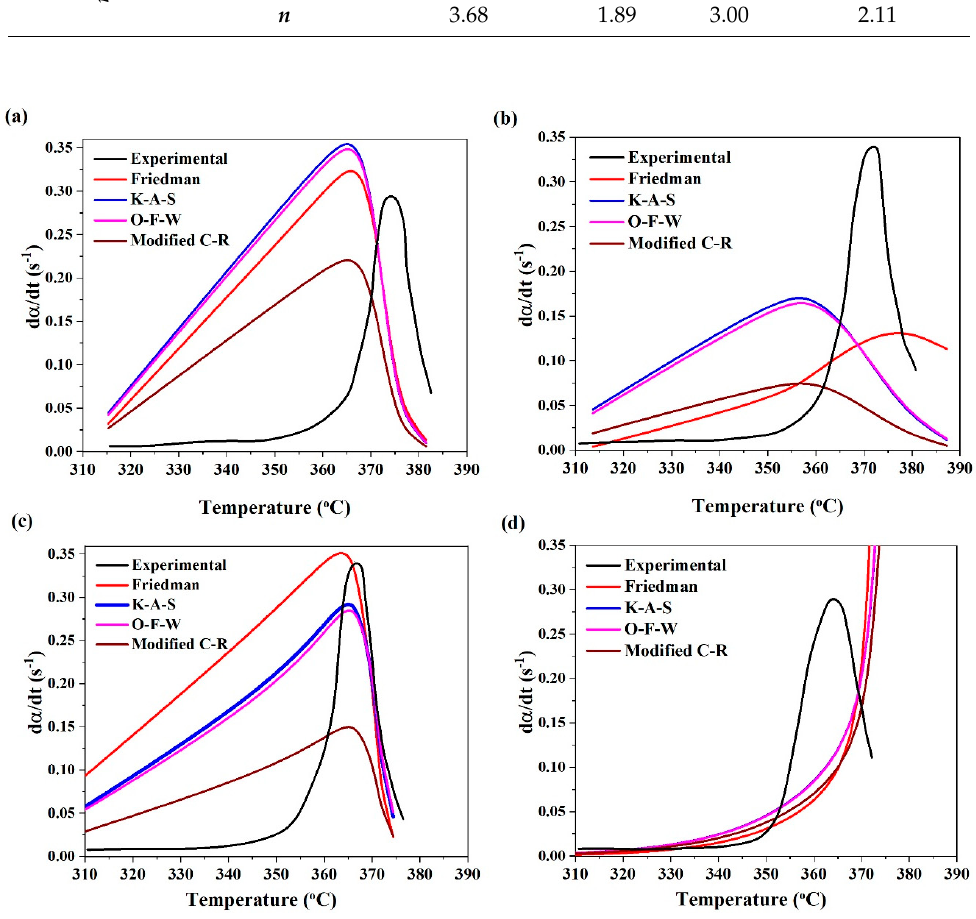
Figure 8. Predicted kinetics plots based on the n th order decomposition reaction model for blank PU and its nanocomposites containing various V-ZrO 2 loadings at the heating rate of 5 °C·min − 1 : ( a ) Blank PU; ( b ) PU/V-ZrO 2 -1; ( c ) PU/V-ZrO 2 -3; and ( d ) PU/V-ZrO 2 -5.